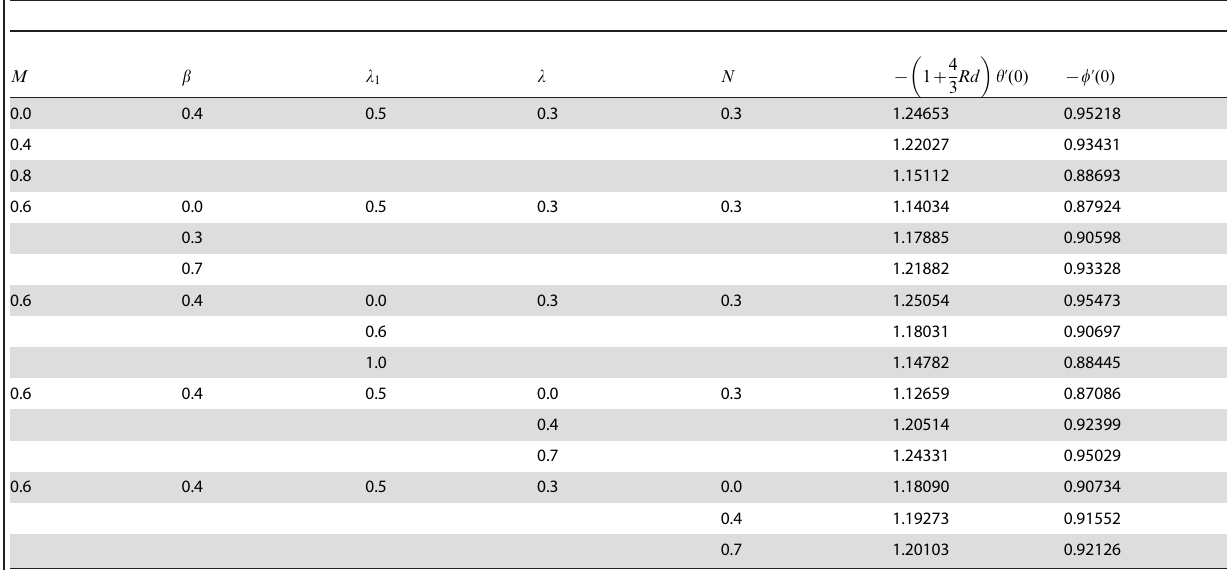
Table 4. Values of local Nusselt number { 1 z and N when Pr ~ 1 : 2, S ~ 0 : 2 ~ S (cid:2) , Rd ~ 0 : 4 and Sc ~ 1 : 0 :